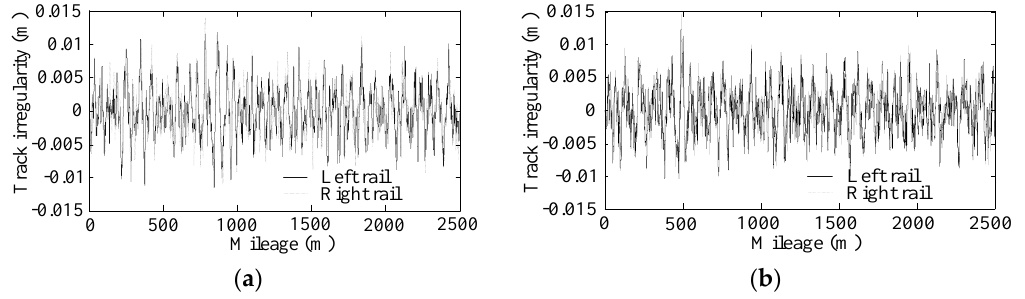
Figure 15. Simulation sample of track irregularity: ( a ) transverse; ( b ) vertical.